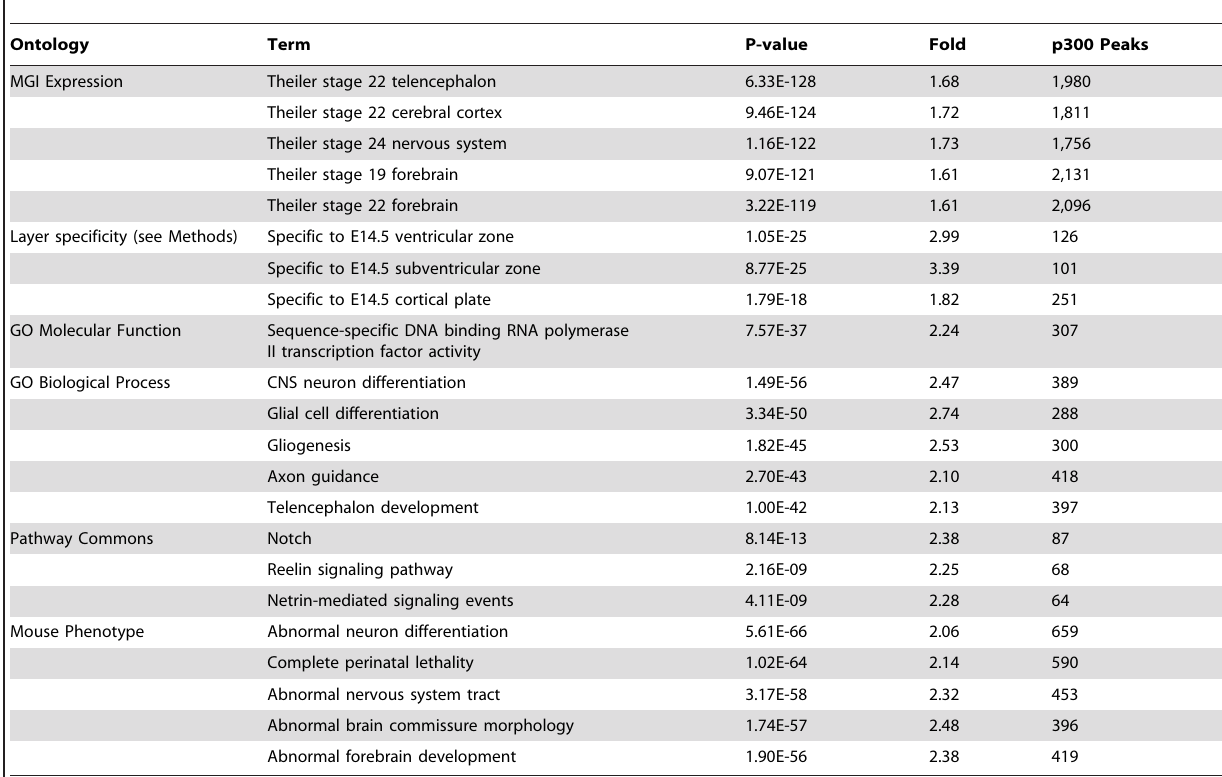
Table 1. Top GREAT enrichments for the E14.5 dorsal cerebral wall p300 ChIP-seq set.